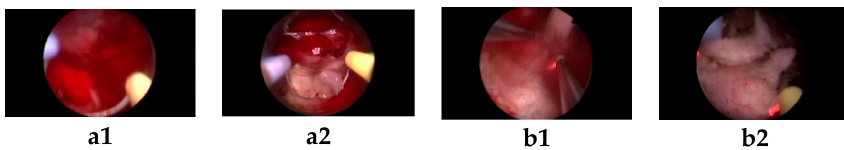
Figure 10. The images of false classification in the confusion matrix of Table 4. ( a1 , a2 ) Examples of FN images. ( b1 , b2 ) Examples of FP images.